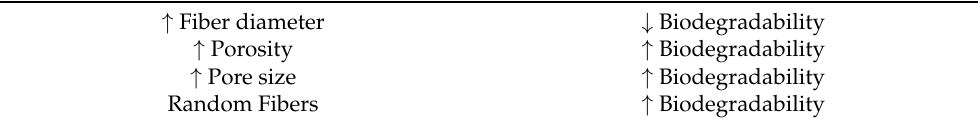
Table 6. Biodegradability of an NGC with the different morphological characteristics. ↑ and ↓ means increasng and